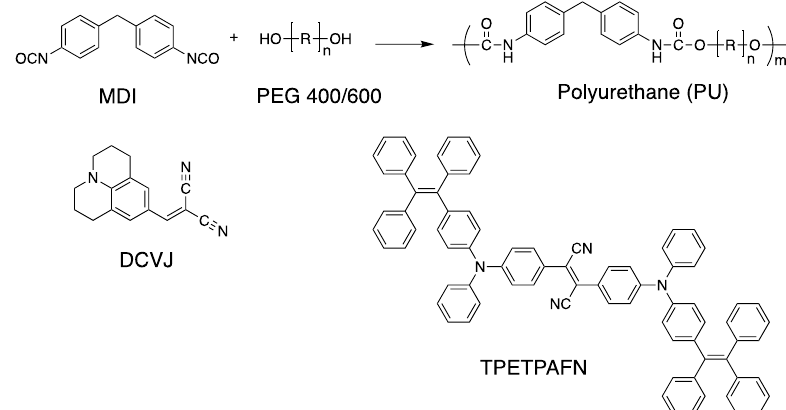
Figure 1. Synthesis of polyurethane from 4,4′-methylenediphenyl diisocyanate (MDI) and polyethylene glycol and the chemical structure of the aggregation-induced emission molecules (AIEgens) investigated in this work.